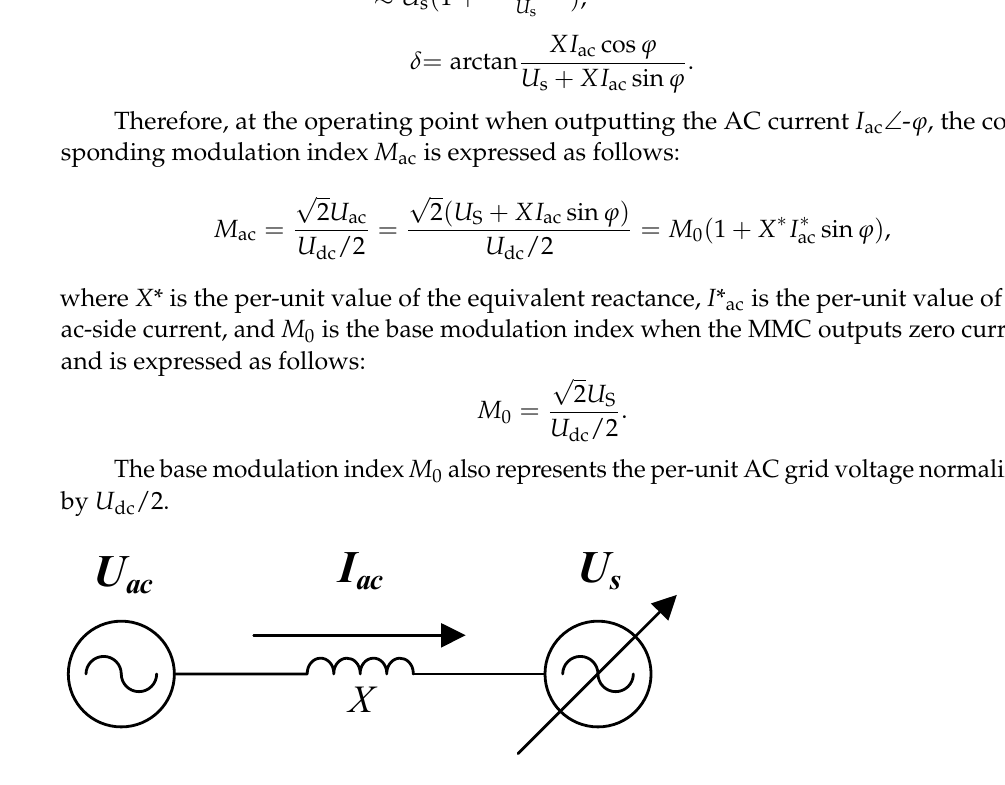
Figure 2. Equivalent circuit of the MMC connected to the AC grid.